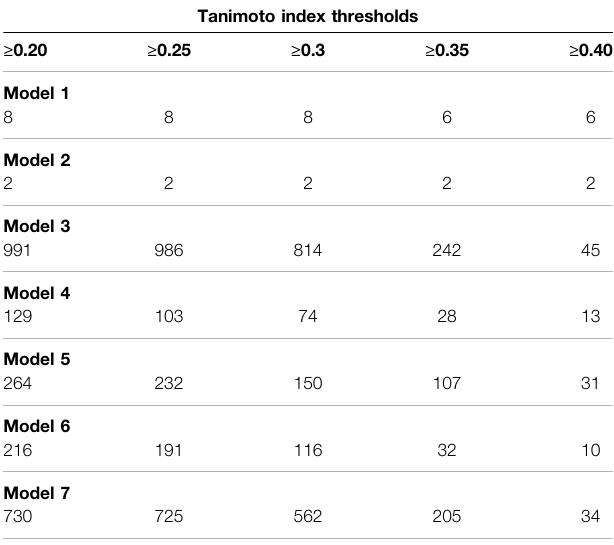
TABLE 8 | Number of compounds selected from each pharmacophore model in different thresholds of similarity values (Tanimoto index) in relation to Roc-A. Tanimoto index